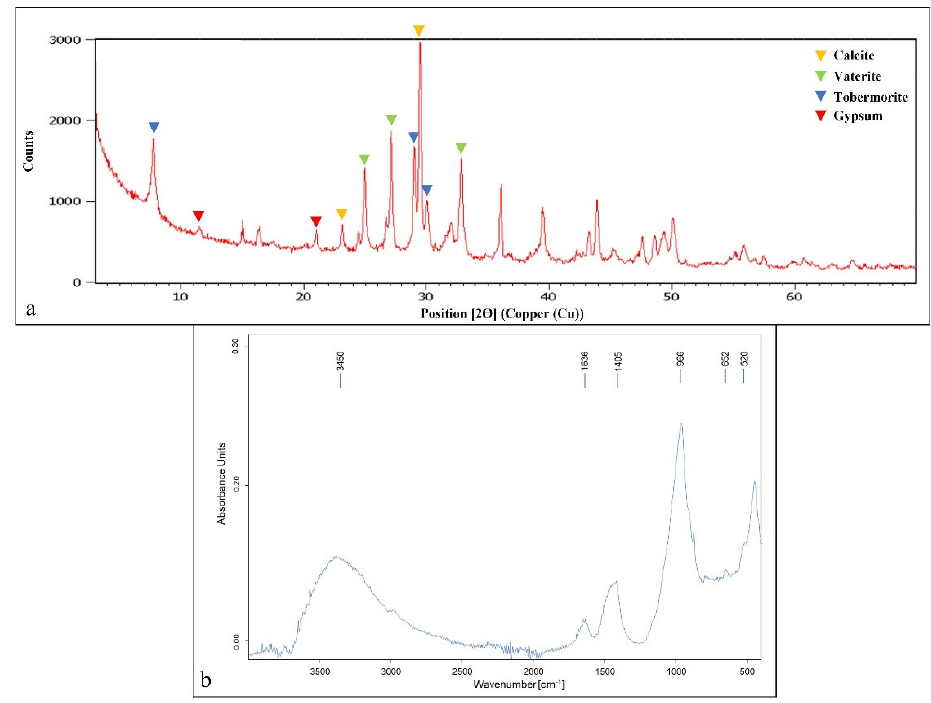
Figure 4. XRD pattern of sample C2-X lump. The most intense peaks for calcite, vaterite, tobermorite and gypsum are indicated ( a ). FTIR spectra of sample C2-X lump. The vibrational bands of tobermorite are highlighted ( b ).